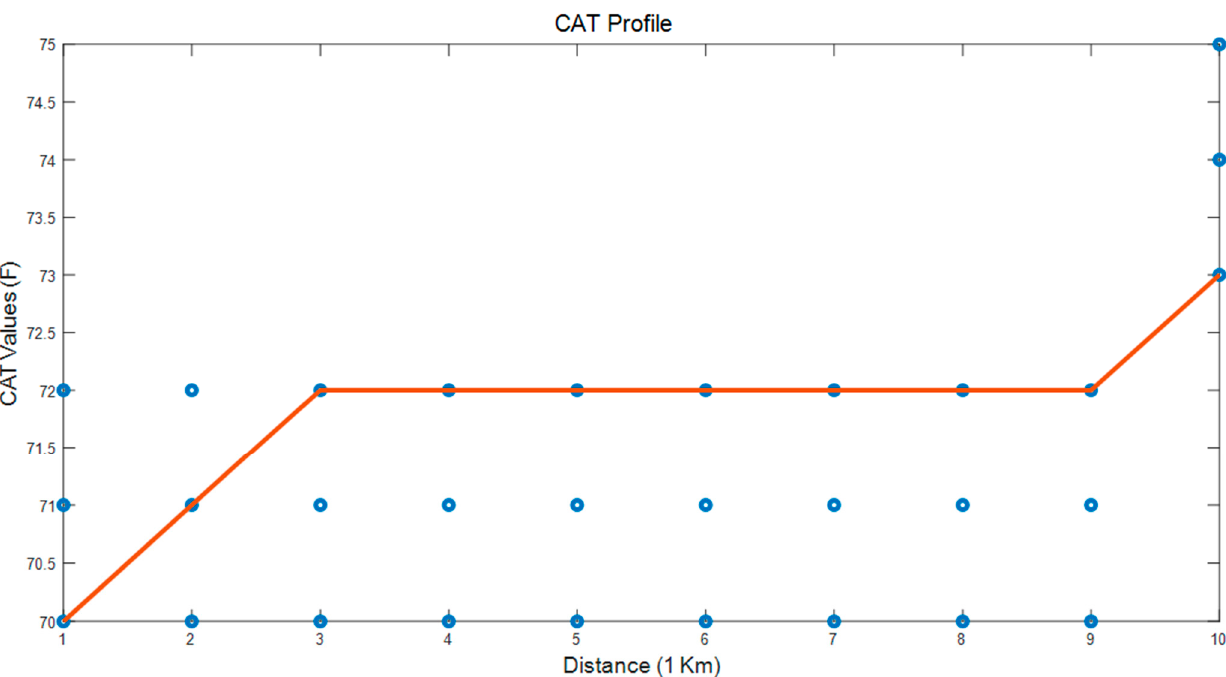
Figure 11. ACCSSP = 70 MPH; Initial CAT = 70 °F; EAT = 38.3 °F.